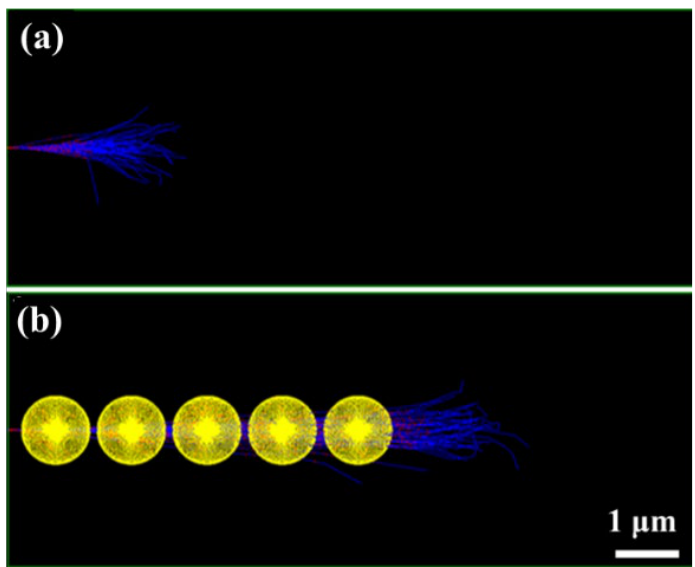
Figure 2. The transport behavior calculated by GEANT4: ( a ) Solid. ( b ) Geometric structure containing voids. (The black box represents the solid materials; the yellow balls represent the voids; the blue lines represent the ion tracks.).